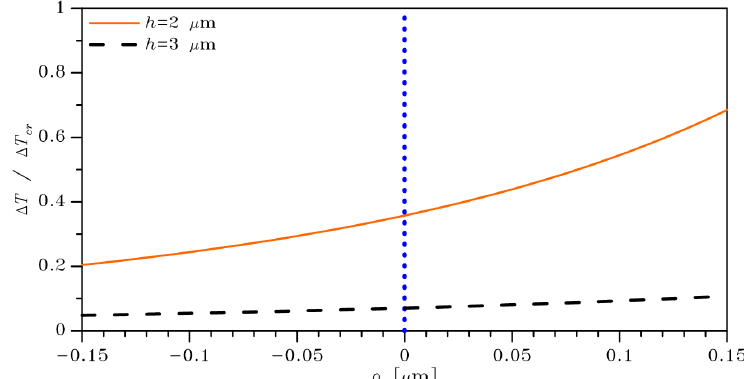
Figure 5. Sensitivity analysis: dependence on the over-etch depth o of the ratio between the temperature raise ∆ T at mid-span, as induced by Joule e ff ect, and its critical value ∆ T cr .